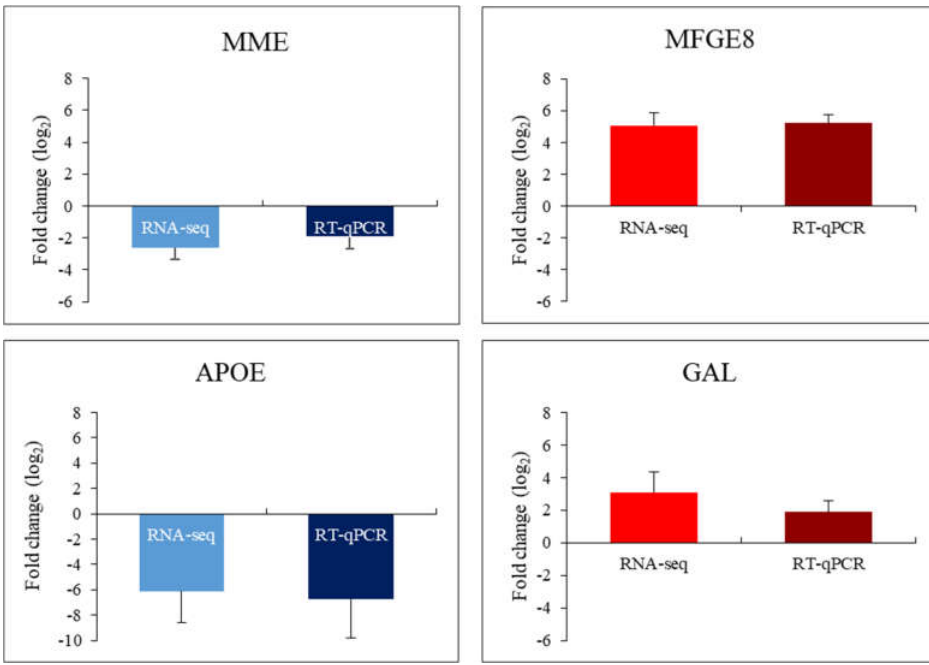
Figure 4. Diagrams presenting comparison of results indicating changes in the expression of selected genes by the RNA-seq and RT-qPCR methods (MME gene in MPS I; MFGE8 gene in MPS IIIA; APOE gene in MPS IIIA; GAL gene in MPS VI).